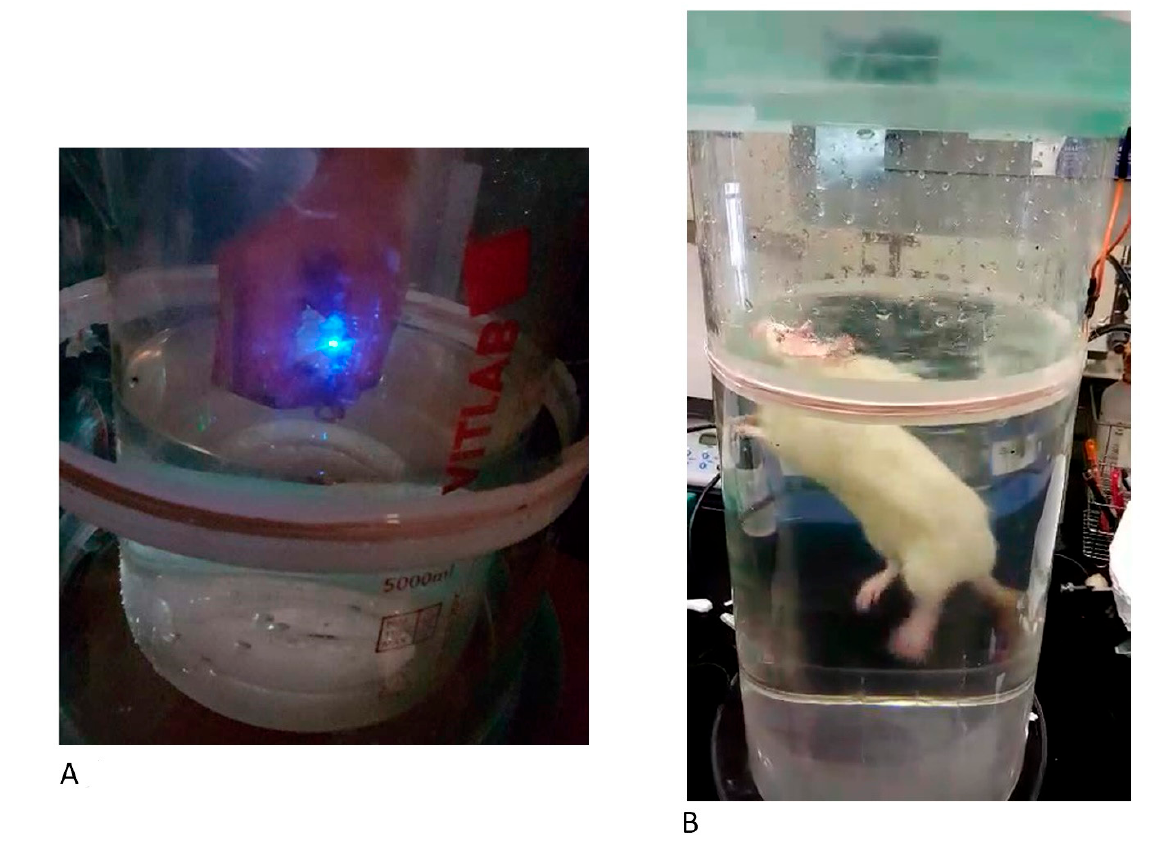
Figure 8. Depression behavior test in the forced-swimming test with optogenetic photostimulation. ( A , B ) These images depict depression behavior testing during the forced-swimming test; the optical fiber was implanted into the medial prefrontal cortex (mPFC).